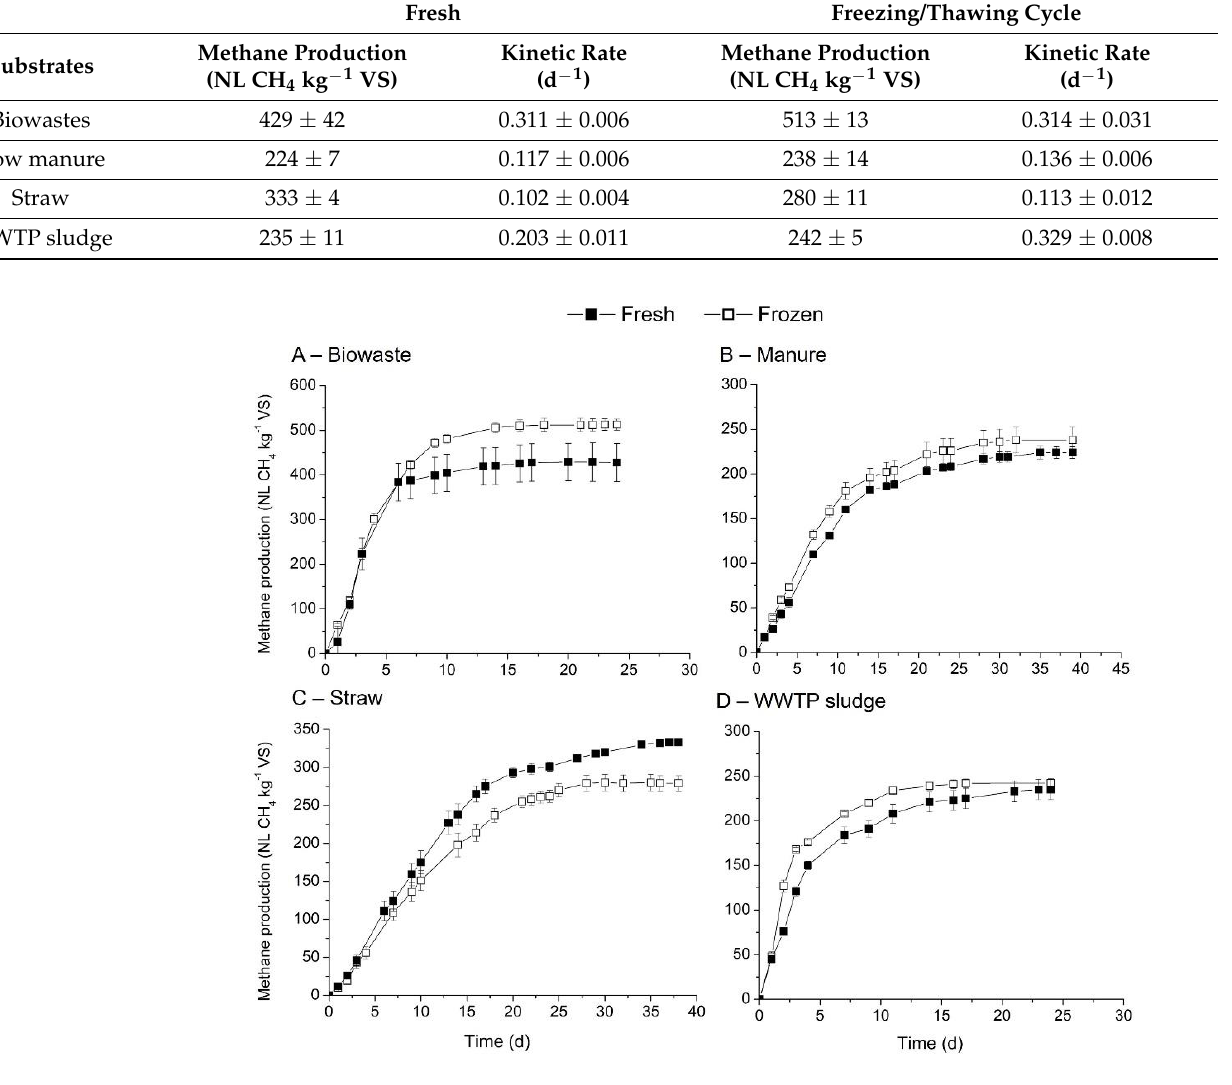
Figure 3. Comparison of methane production and kinetics between fresh and freezing/thawing cycle substrates: ( A ) biowastes, ( B ) cow manure, ( C ) straw and ( D ) WWTP sludge.